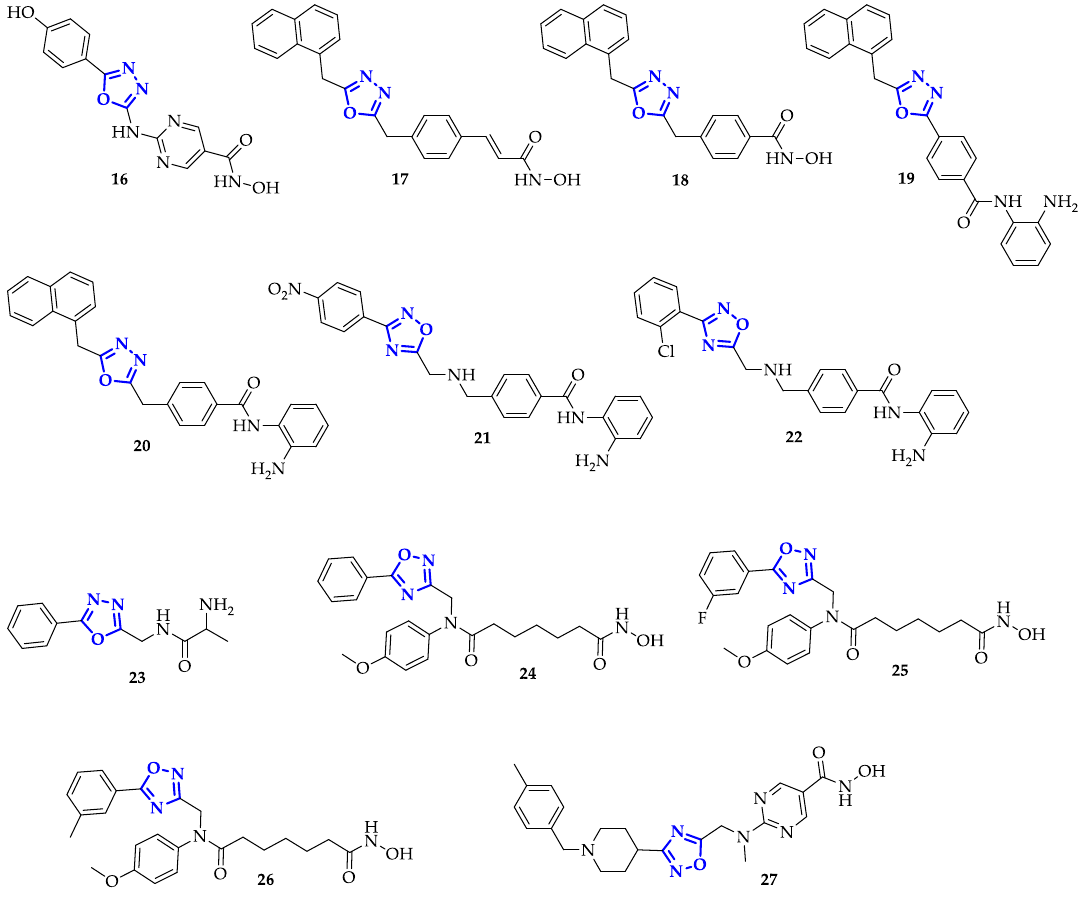
Figure 5. Example of oxadiazoles ligands able to efficiently inhibit histone